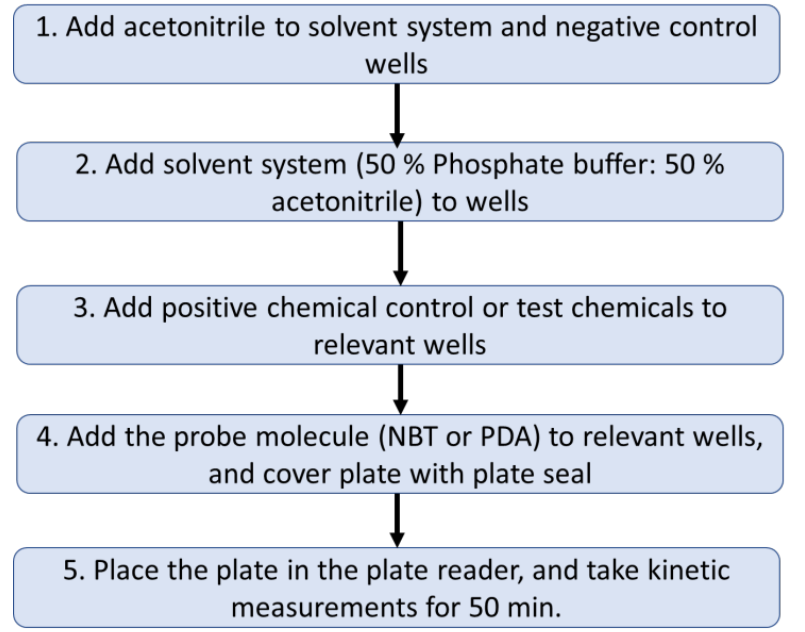
Figure 2. Flow chart outlining the main steps for the EASA method.